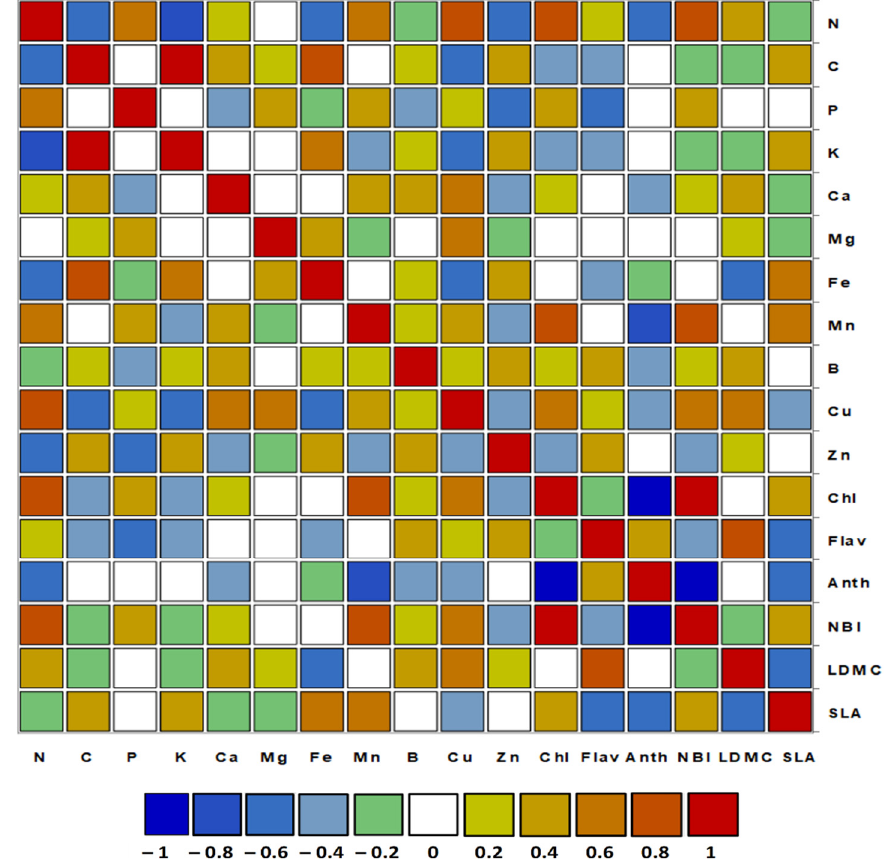
Figure 3. Heatmap of Pearson’s correlation among the analyzed variables. Data from leaf diagnostics, content of total chlorophyll, flavonol, anthocyanin and nitrogen balance index and leaf biometrics recorded at 120 DAFB were compared. Positive correlations with high values as well as self-correlations are red colored while negative ones are blue colored. The other levels of correlations are indicated with different shades of colors according to the figure caption. Numerical values and the significance of correlations are shown in Supplemental Table S2. (Level of correlation: 1.0–0.8 very high; 0.8–0.6 high; 0.6–0.4, moderate; 0.4–0.2, low; 0.2–0: negligible correlation).